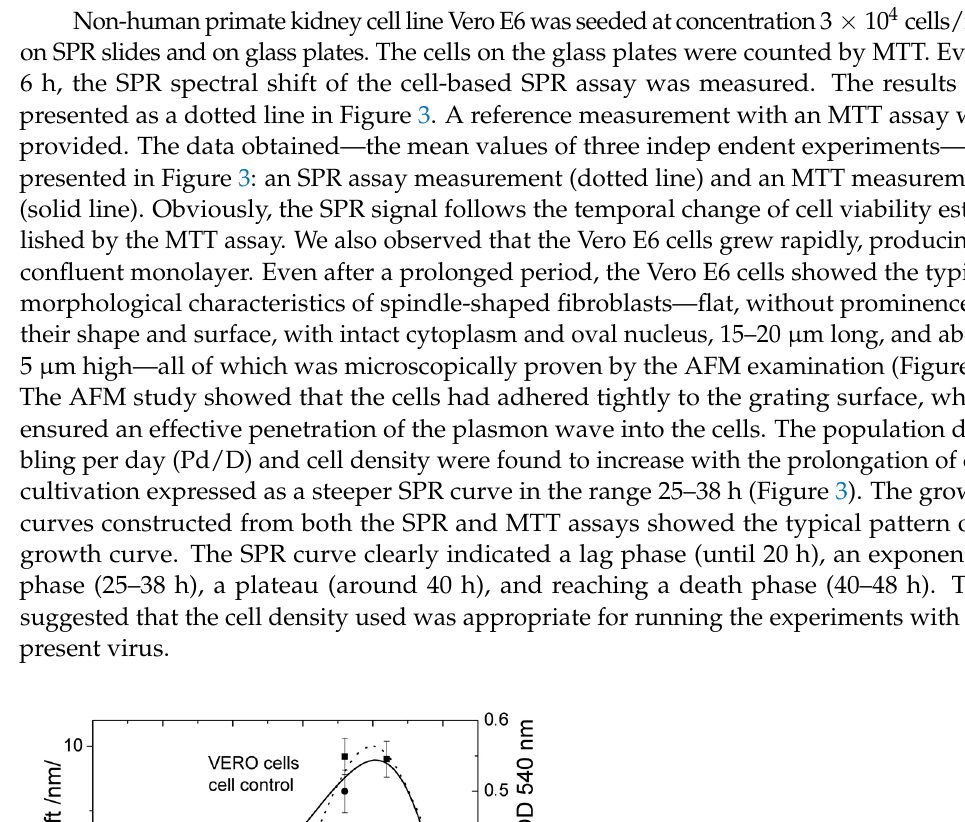
Figure 4. Vero cell at 24 h p.i .; AFM scan of the diffraction grating. 3.2. Viral Growth Kinetics To estimate the viral growth curve characteristics, the infectivity titer of HCOV-229E was determined every 6 h p.i. by MTT (solid curve in Figure 5). The MTT assay measure- ment revealed the main phases of the viral growth kinetics. The initial increase in viability by 10 h is due to an increase in the number of uninfected cells as a result of the cell growth process. Figure 5. Growth kinetics of HCoV-229E-infected cells: dotted line—SPR results (virus control); solid line—MTT results.